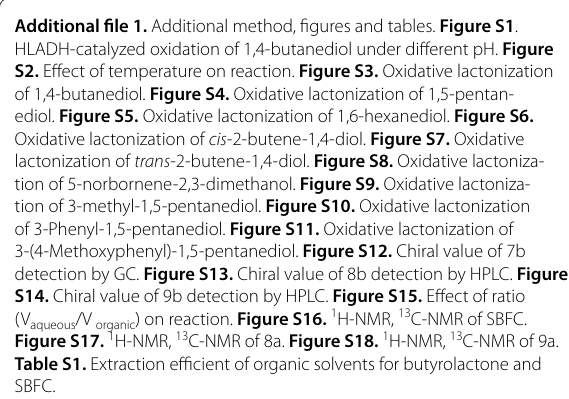
Table S1. Extraction efficient of organic solvents for butyrolactone and